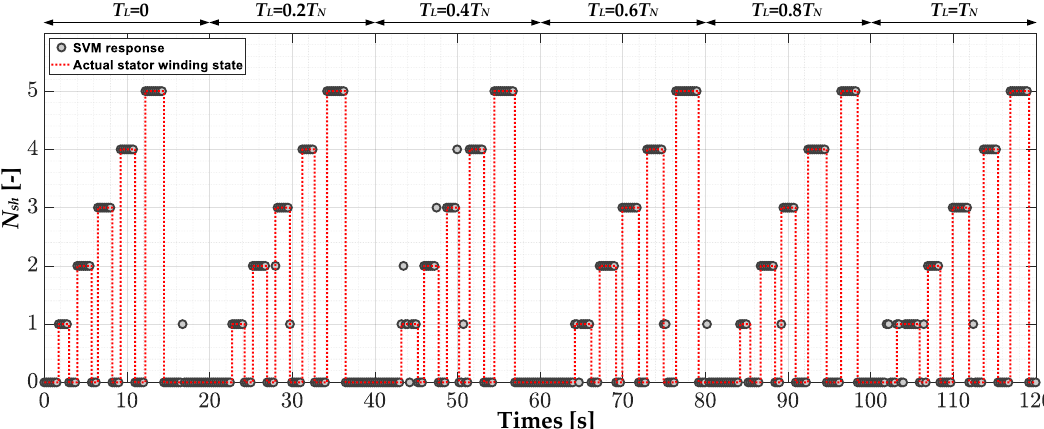
Figure 21. The actual states of the stator windings and SVM model responses of the fault classifier models for on-line operation of the PMSM drive.